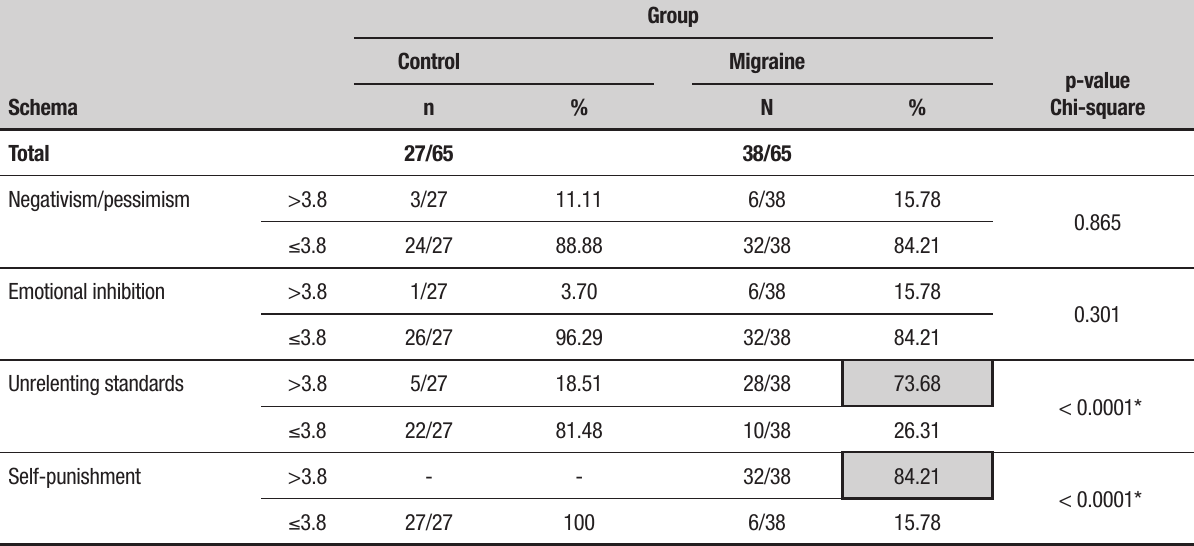
Table 3. Evaluation of early maladaptive schemas related to hypervigilance and inhibition according to group.